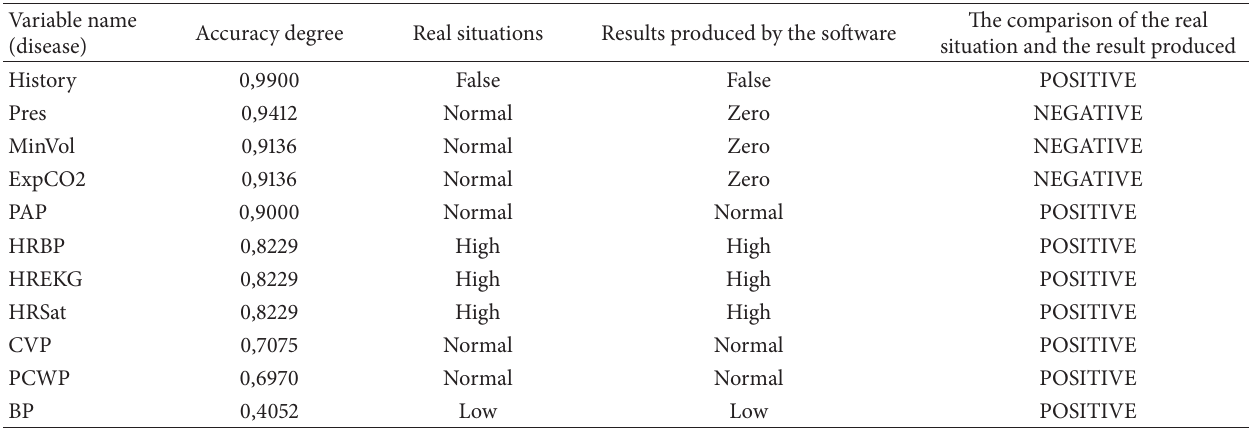
Table 1: 11 Output variables for one record (100 datasets).